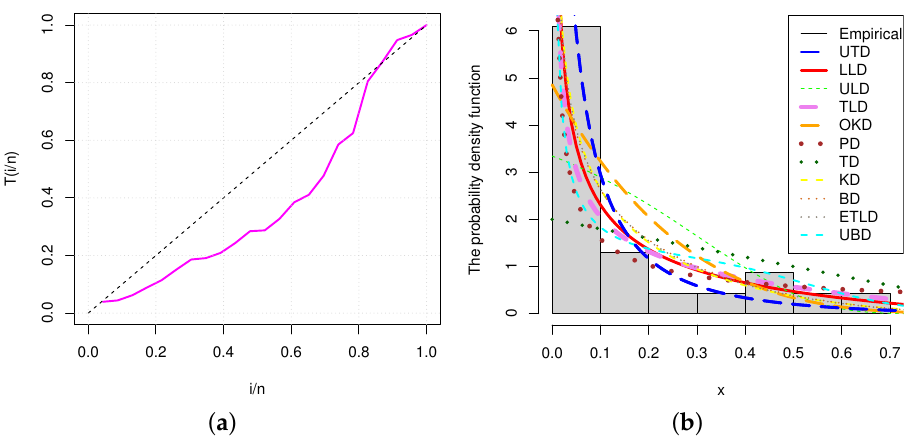
Figure 6. ( a ) TTT plot and ( b ) histogram for secondary reactor pumps